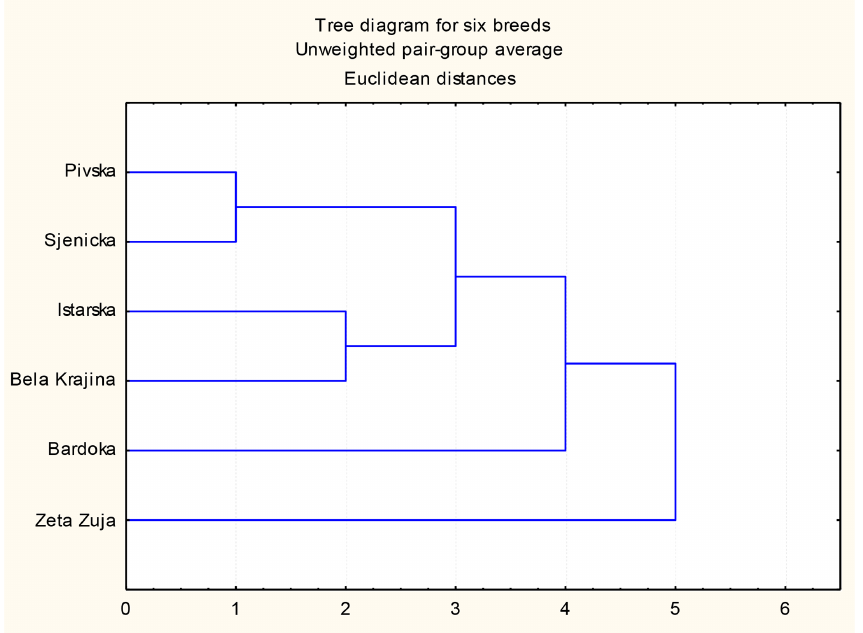
Figure 3. UPGMA tree diagram of distances among six sheep breeds obtained based on means for morphometric